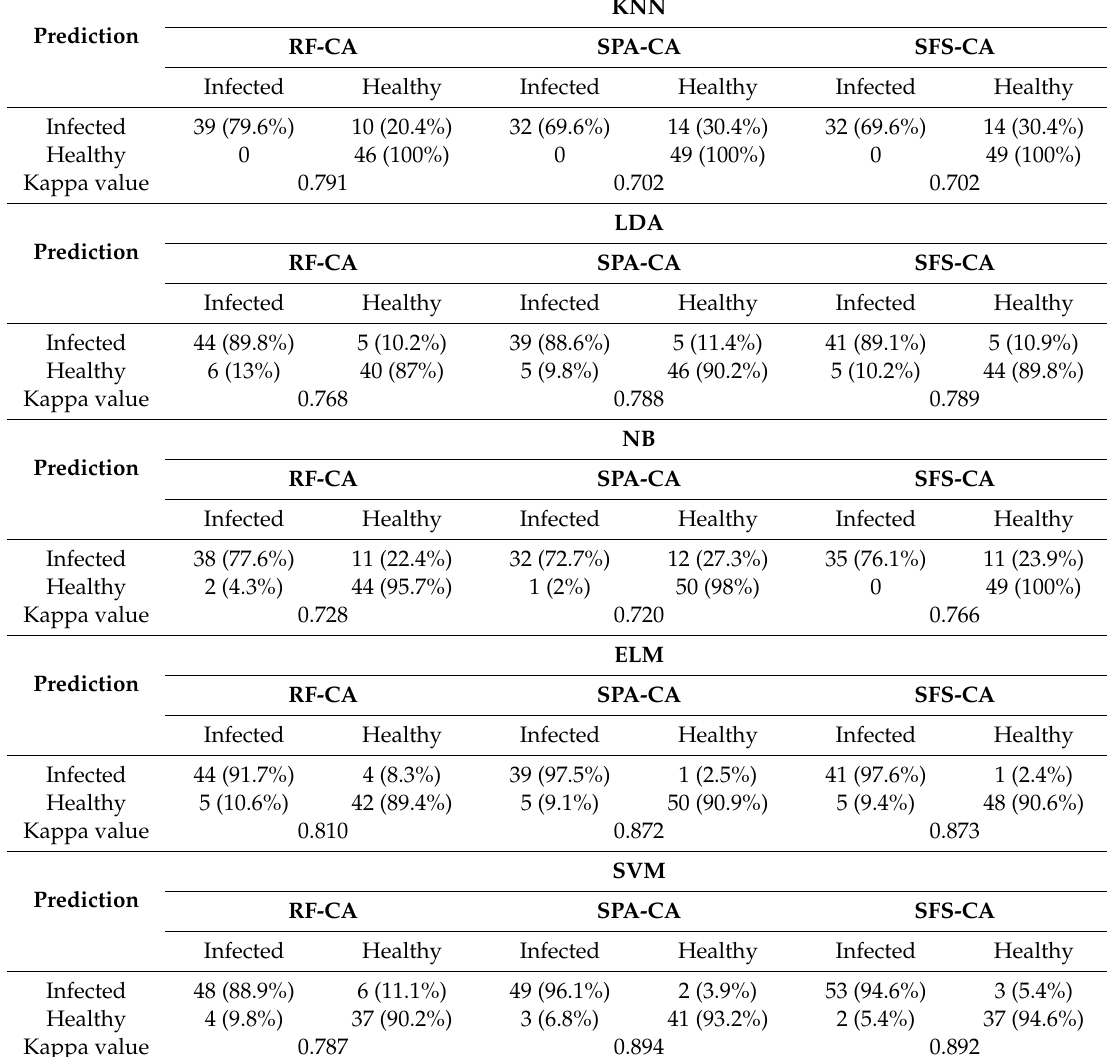
Table 3. The classification results of models based on the optimal